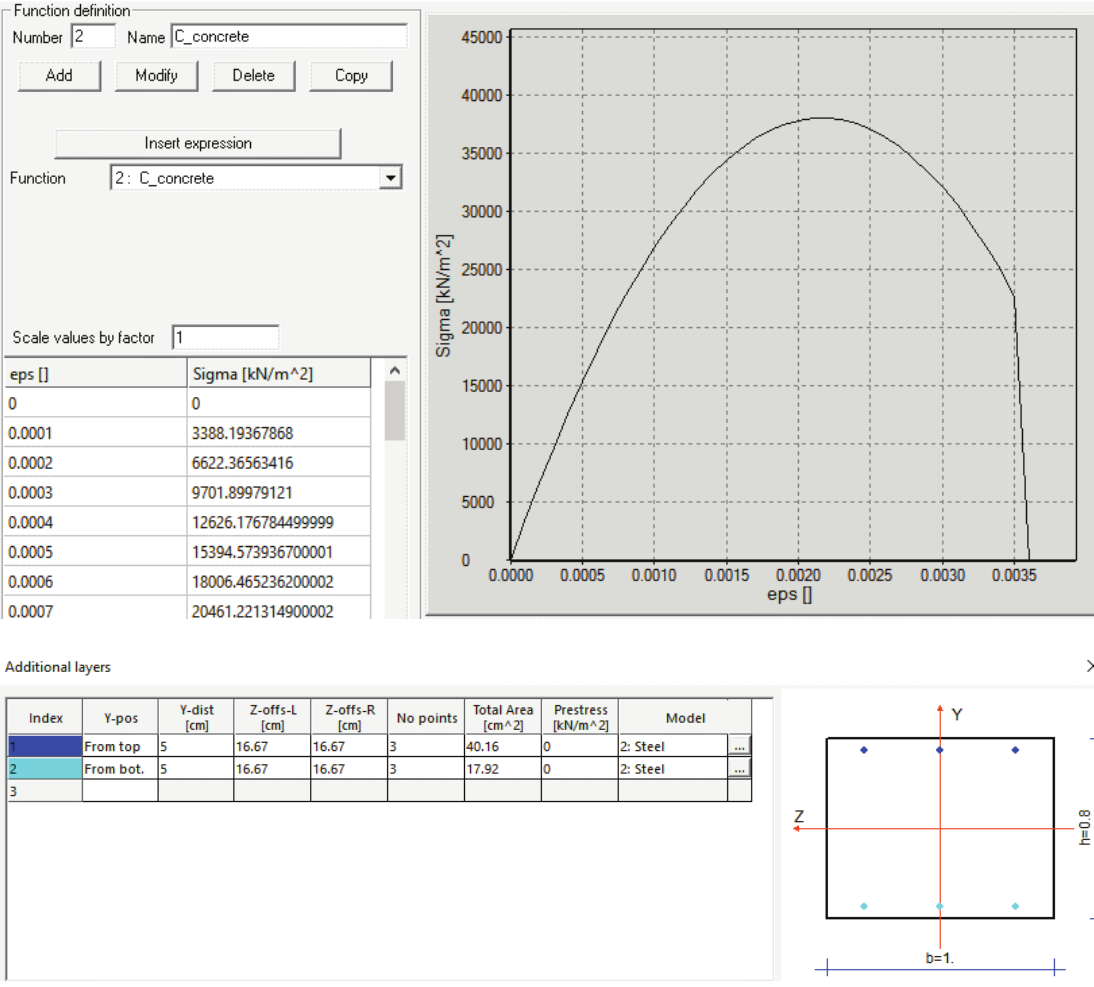
Fig. 3. Adopted stress-strain relation for non-linear structural